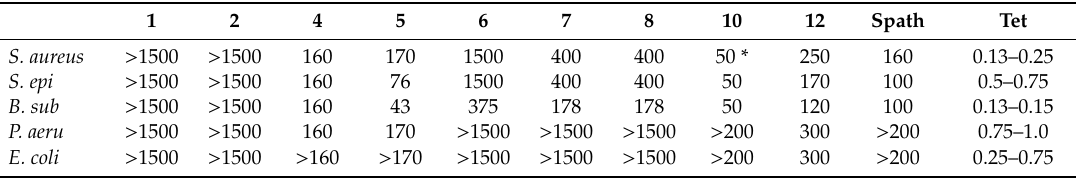
Table 1. Yields of isolates 1–12 in % ( g/g ). C.e— Callitris endlicheri , C.c— C. columellaris , W.s— Widdringtonia schwartzii , W.c— W. wallichii , W.n— W. nodiflora . (L)—Leaves, (Tw)—Twigs, (Ti)— Timber, (C)—cones. Sandaracopimaric acid ( 1 ), Z -communic acid ( 2 ), E -communic acid ( 3 ), 12-